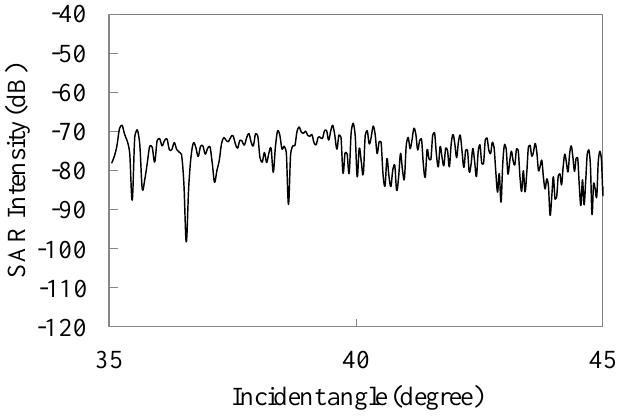
Figure 16. Incident angle dependence of simulated SAR intensity in range direction (wind speed 5